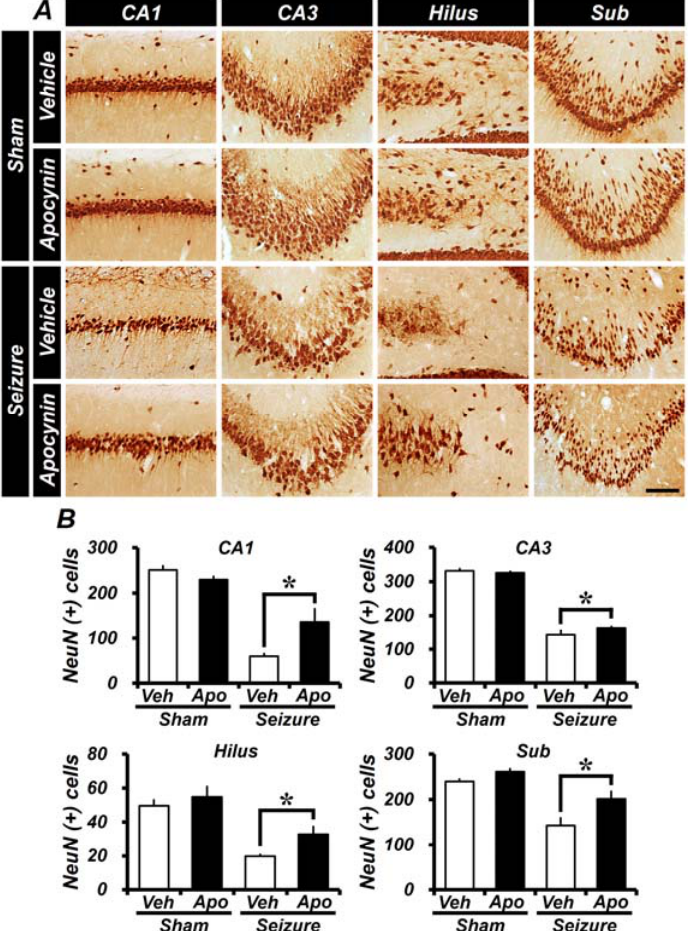
Figure 4. Apocynin treatment reduces neuronal cell loss induced by seizures. ( A ) Live neurons or mature neurons in the hippocampus were identified by NeuN immunohistochemical staining. Scale bar = 100 µ m. ( B ) Bar graph showing the number of NeuN + neurons in the hippocampus treated with apocynin for 4 weeks after seizures. Among the two groups receiving seizures, the apocynin-treated group had a greater number of neurons when NeuN + cells were compared to the vehicle-treated group. Seizure-induced NeuN + neuron loss was prevented by apocynin treatment in the hippocampus each region compared to the vehicle treatment. Data: Mean ± S.E.M., n = 5–8 from each group, * p < 0.05.